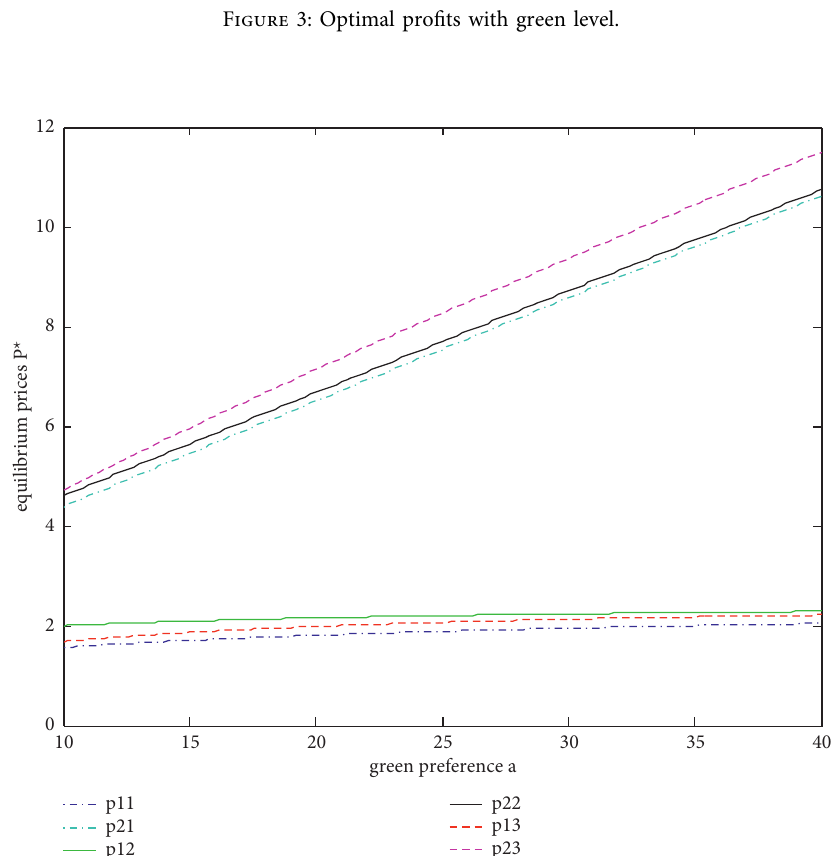
Figure 4: Equilibrium prices with green preference.